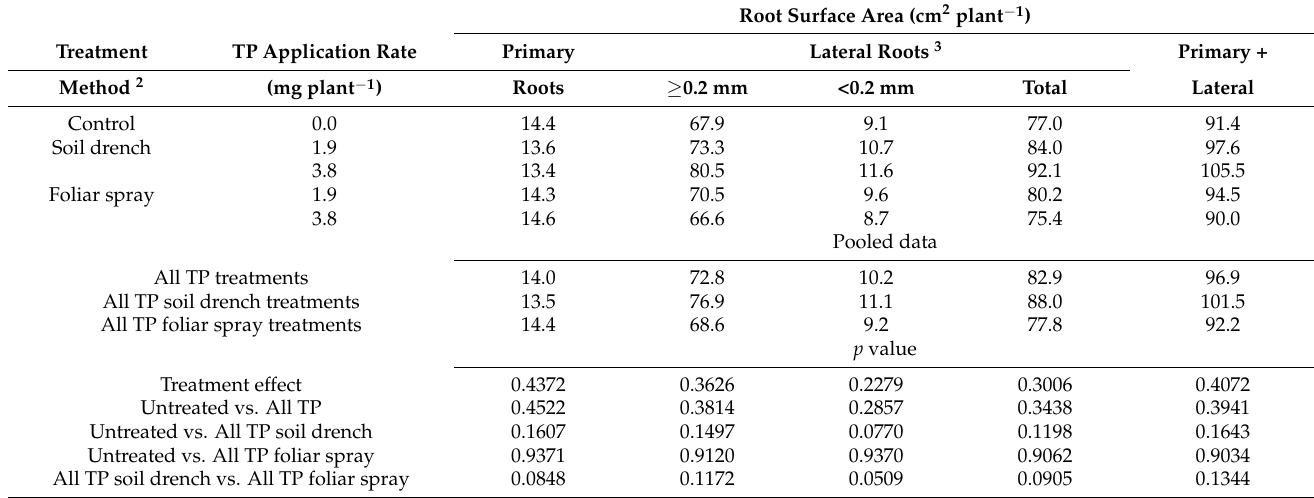
Table 5. Root surface area of soybean seedlings as affected by tryptophan (TP) soil drench and foliar spray treatments 1 .